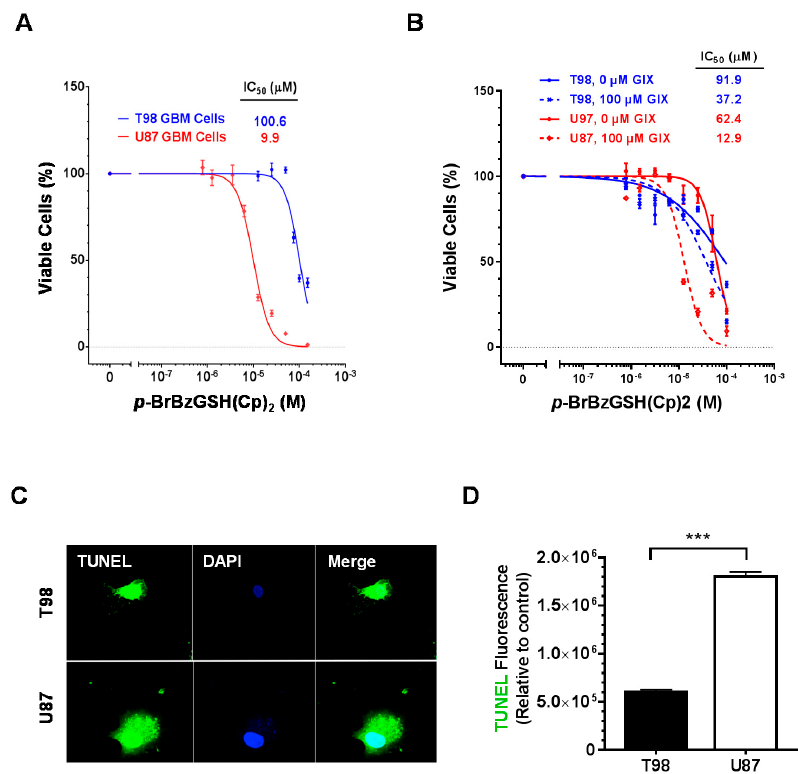
Figure 3. GLO1 inhibition triggered cell death and apoptosis in GBM cells. ( A ) IC 50 determination following 24 h treatment of U87 and T98 GBM cells with p -BrBzGSH(Cp) 2 ; ( B ) IC 50 curves for treatment of T98 and U87 GBM cells with p -BrBzGSH(Cp) 2 following 24 h pretreatment with ADAM10 inhibitor GI254023X (100 µM GIX) or control (0 µM GIX); ( C ) TUNEL-FITC and DAPI imaging of T98 and U87 GBM after treatment with 30 µM p -BrBzGSH(Cp) 2 for 24 h; ( D ) Quantification of TUNEL fluorescence in p- BrBzGSH(Cp) 2 treated T98 and U87 cells normalized to untreated controls. *** p < 0.001. Error bars indicate the mean ± SEM.